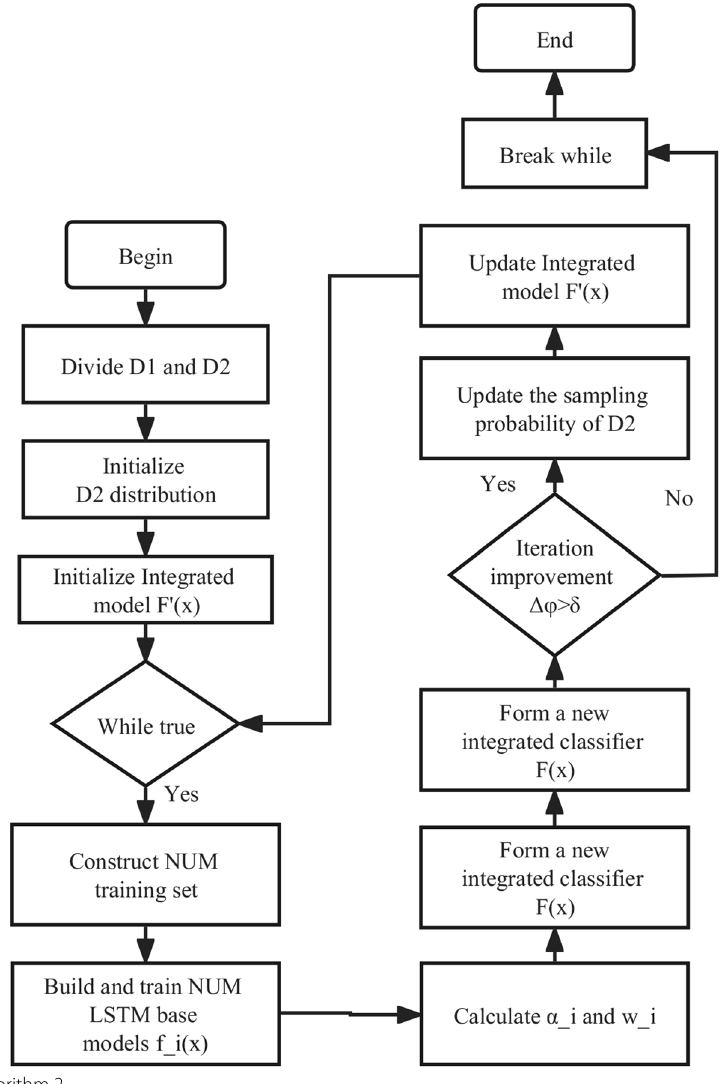
Fig. 7 The flowchart of Algorithm